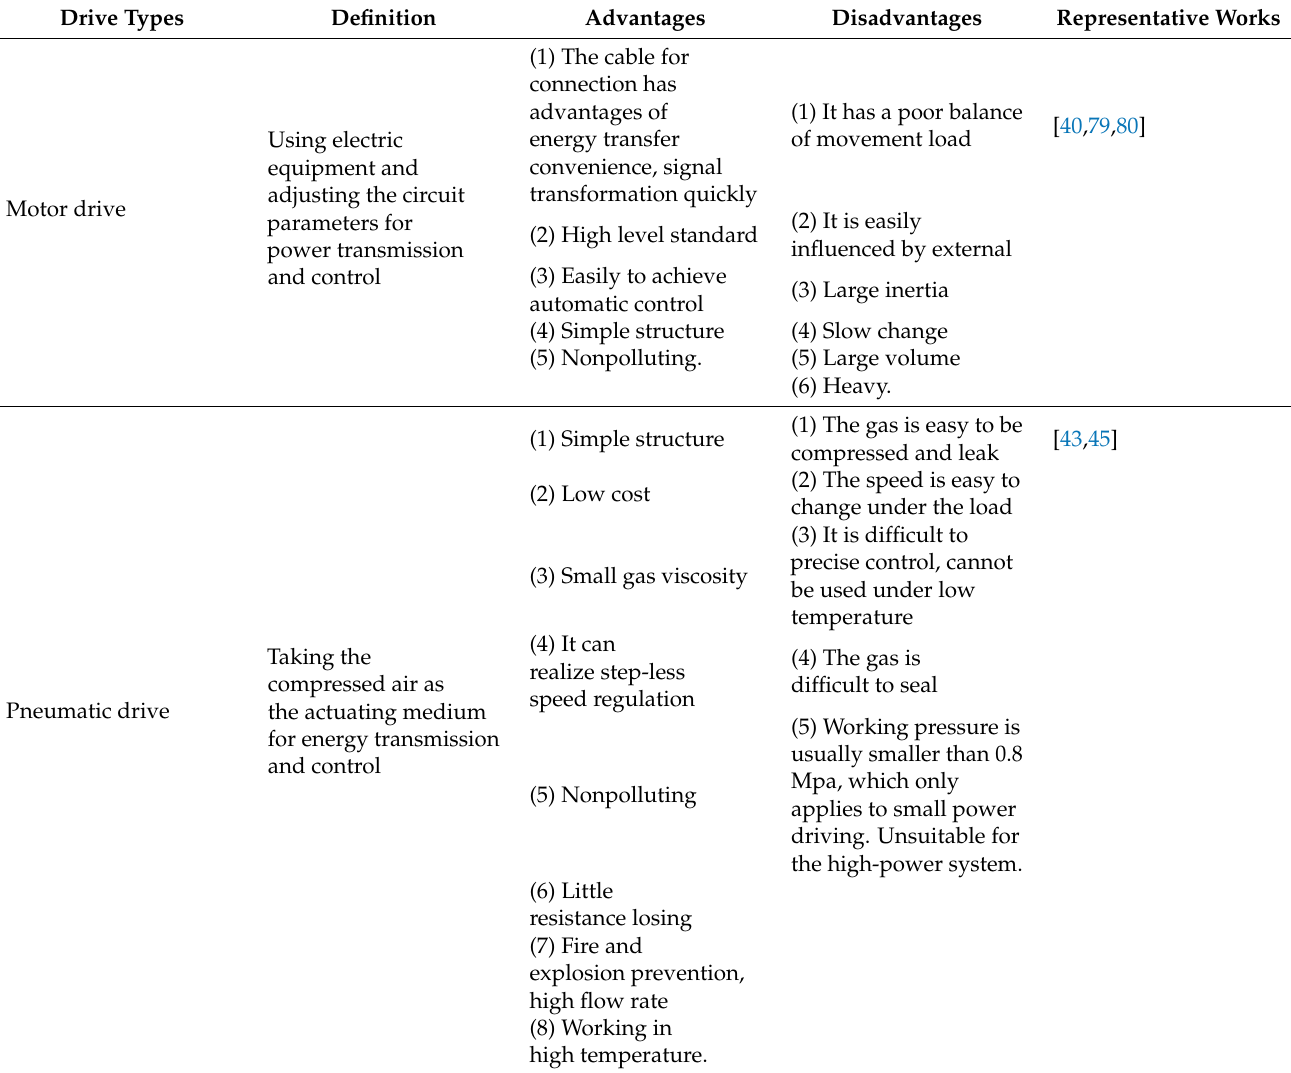
Table 2. Overview of drive modes for hand rehabilitation